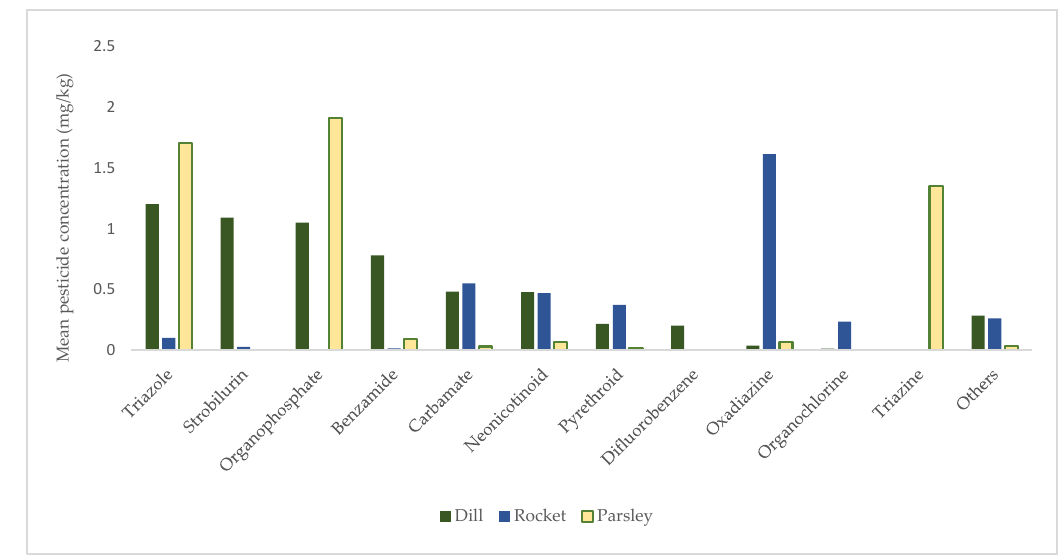
Figure 2 . Main class of pesticides detected in green leafy vegetables. Figure 2. Main class of pesticides detected in green leafy